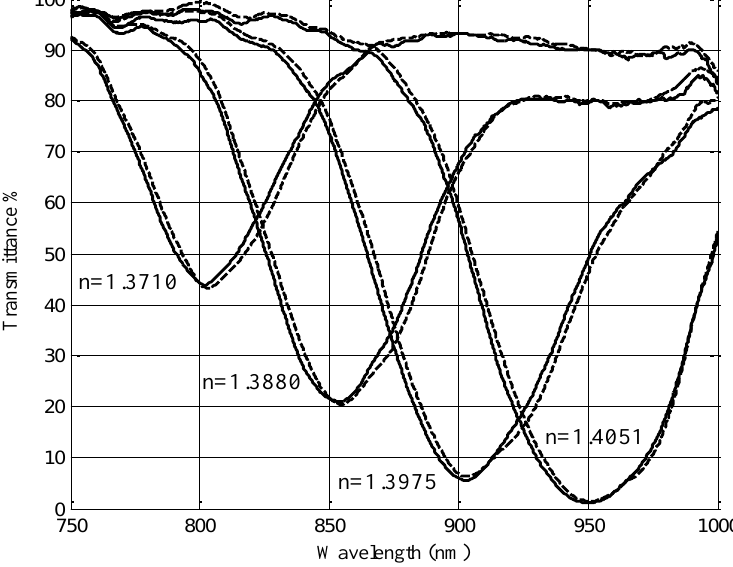
Figure 4. Representative experimental behavior of symmetrically deposited DLUWTs: a wide plasmon dip, that displaces itself when refractive index of the outer medium changes and no polarization dependence (continuous and dashed lines show use or not use of controlling elements (originally published in [8] and reproduced by kind permission of Springer Science + Business